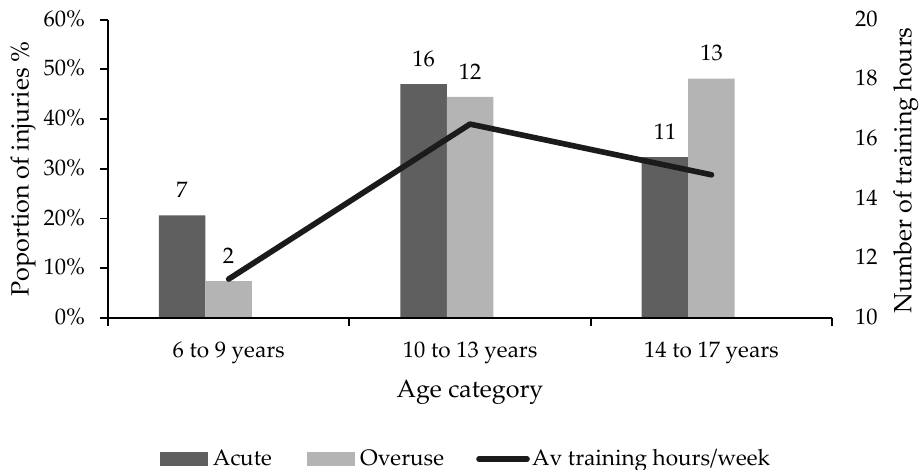
Figure 5. Proportions of acute and severe injuries distributed across three age categories, with the average training hours per week reported by age category.